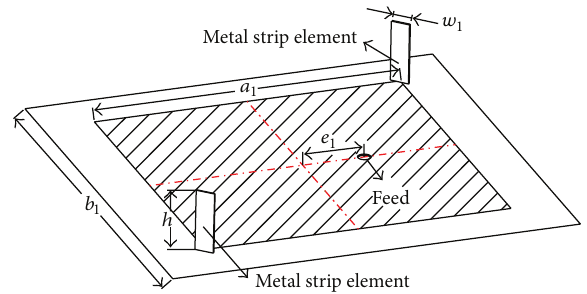
Figure 1: Configuration of the L1 band antenna.